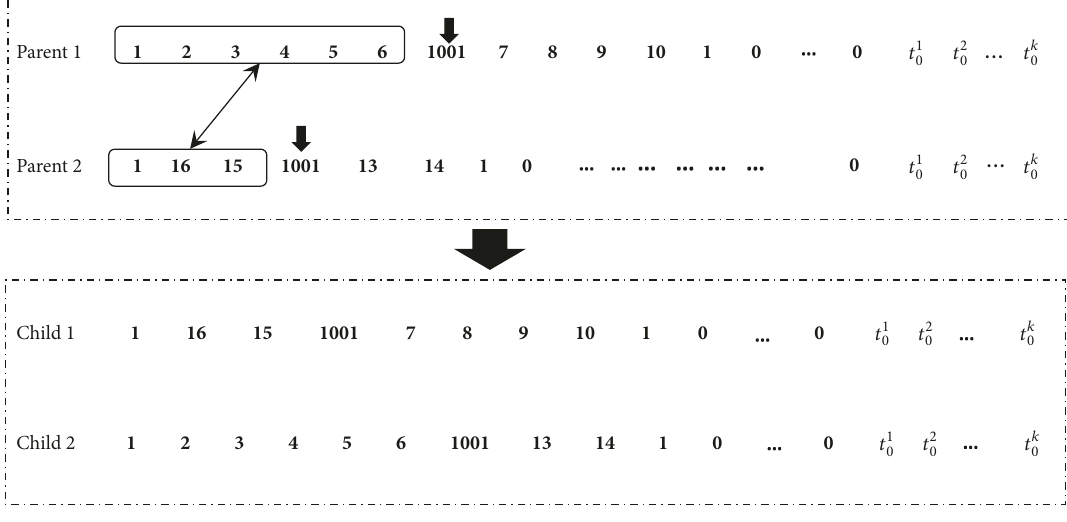
Figure 2: Crossover